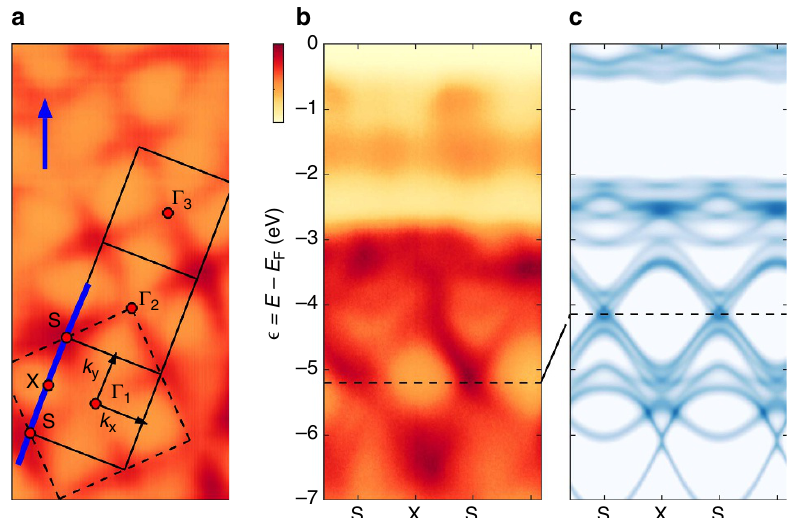
Figure 1 | Oxygen band structure of Ca 2 RuO 4 . ARPES recorded with right-handed circularly polarized (C þ ) 65eV photons in the paramagnetic (150K) insulating state of Ca 2 RuO 4 , compared to DFT band structure calculations. Incident direction of the light is indicated by the blue arrow. Dark colours correspond to high intensities. ( a ) Constant energy map displaying the photoemission spectral weight at binding energy E ¼ E (cid:2) E F ¼ (cid:2) 5.2eV. Solid and dashed lines mark the in-plane projected orthorhombic and tetragonal zone boundaries, respectively. G i with i ¼ 1, 2, 3 label orthorhombic zone centres. S and X label the zone corners and boundaries, respectively. ( b ) Spectra recorded along the zone boundary (blue line in a ) Oxygen-dominated bands are found between E ¼ (cid:2) 7 and (cid:2) 3eV, whereas the ruthenium bands are located above (cid:2) 2.5eV. ( c ) First-principle DFT band structure calculation. Within an arbitrary shift, indicated by the dashed line, qualitative agreement with the experiment is found for the oxygen